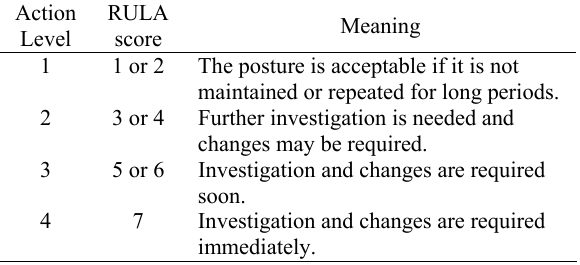
Table 1. Meaning of the final RULA scores